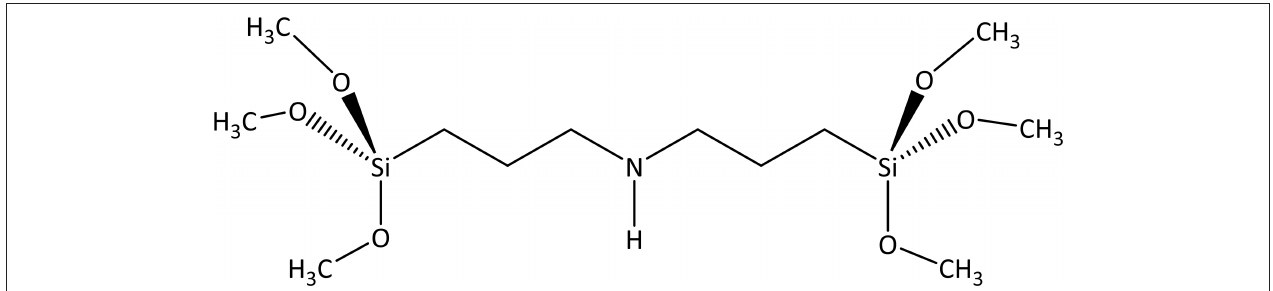
FIGURE 1 | Structure of the BTMSPA